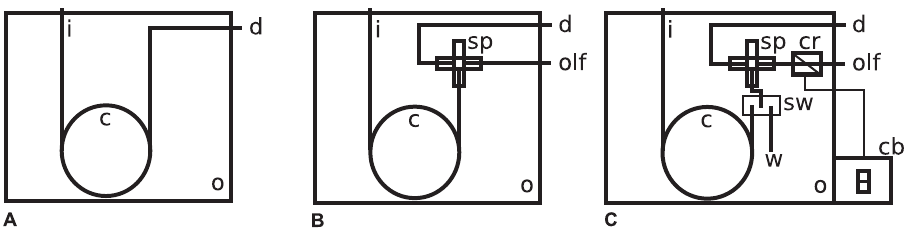
Figure 2. Schematic of (a) standard GC-MS; (b) GC-MS with splitter at end of column for olfactometry; and (c) Gas Chromatograph- Recomposition-Olfactometer or GC-R with Deans switch, splitter, cryogenic trap and olfactory port. Abbreviations: i-inlet; c-column; d- detector; o-oven; olf-olfactometry port; sp-splitter; sw-Deans switch 1; w-waste; cr-cryogenic trap; and cb-switch 2 on control box.